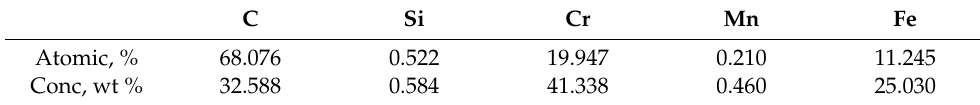
Figure 12. Scanning microscope analysis of reference sample: ( a ) qualitative EDS analyses from Table 2. Quantitative EDS analyses, respectively, from Point 1 (carbide).